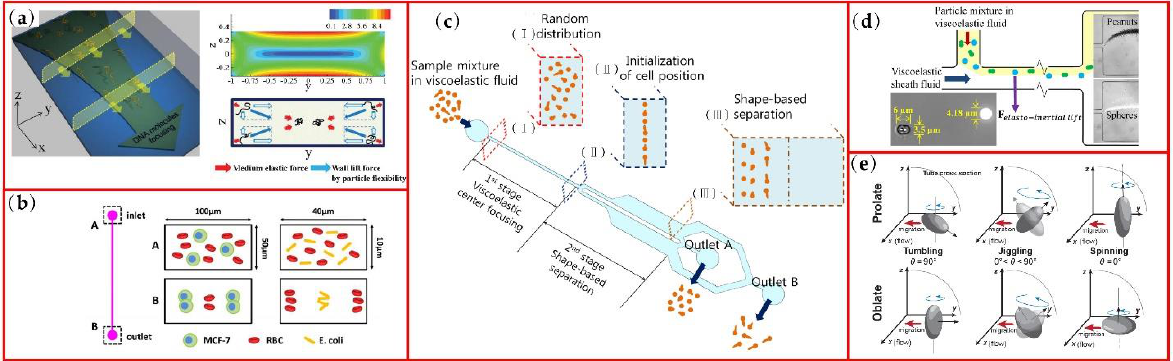
Figure 7. Non-spherical particle manipulation under viscoelastic flows: ( a ) 3D DNA focusing under viscoelastic flows; ( b ) rectangular cross section illustration of separation of MCF-7 cells, RBCs and E.coils; ( c ) schematic of shape-based separation of candida cells in a viscoelastic fluid, reprinted from [95]; ( d ) separation of spherical and peanut-shaped particles under viscoelastic flows; ( e ) possible modes of motion for spherical particles under viscoelastic flows in a circular tube. Figure ( a ) is reprinted with permission from [93], Copyright 2012 RSC Publishing. Figure ( b ) is reprinted with permission from [94], Copyright 2015 American Chemical Society. Figure ( d ) is reprinted with permission from [21], Copyright 2015 American Chemical Society. Figure ( e ) is reprinted with permission from [99], Copyright 2020 John Wiley and Sons.